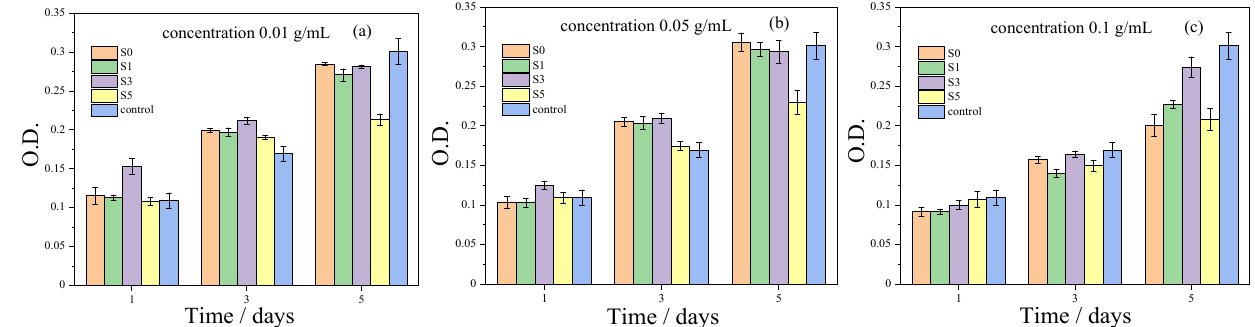
Figure 9. MTT cell viability assay of MC3T3-E1 osteoblast precursor cells exposed to various extract concentrations: ( a ) 0.01 g/mL, ( b ) 0.05 g/mL, and ( c ) 0.1 g/mL, for 1, 3, and 5 days.